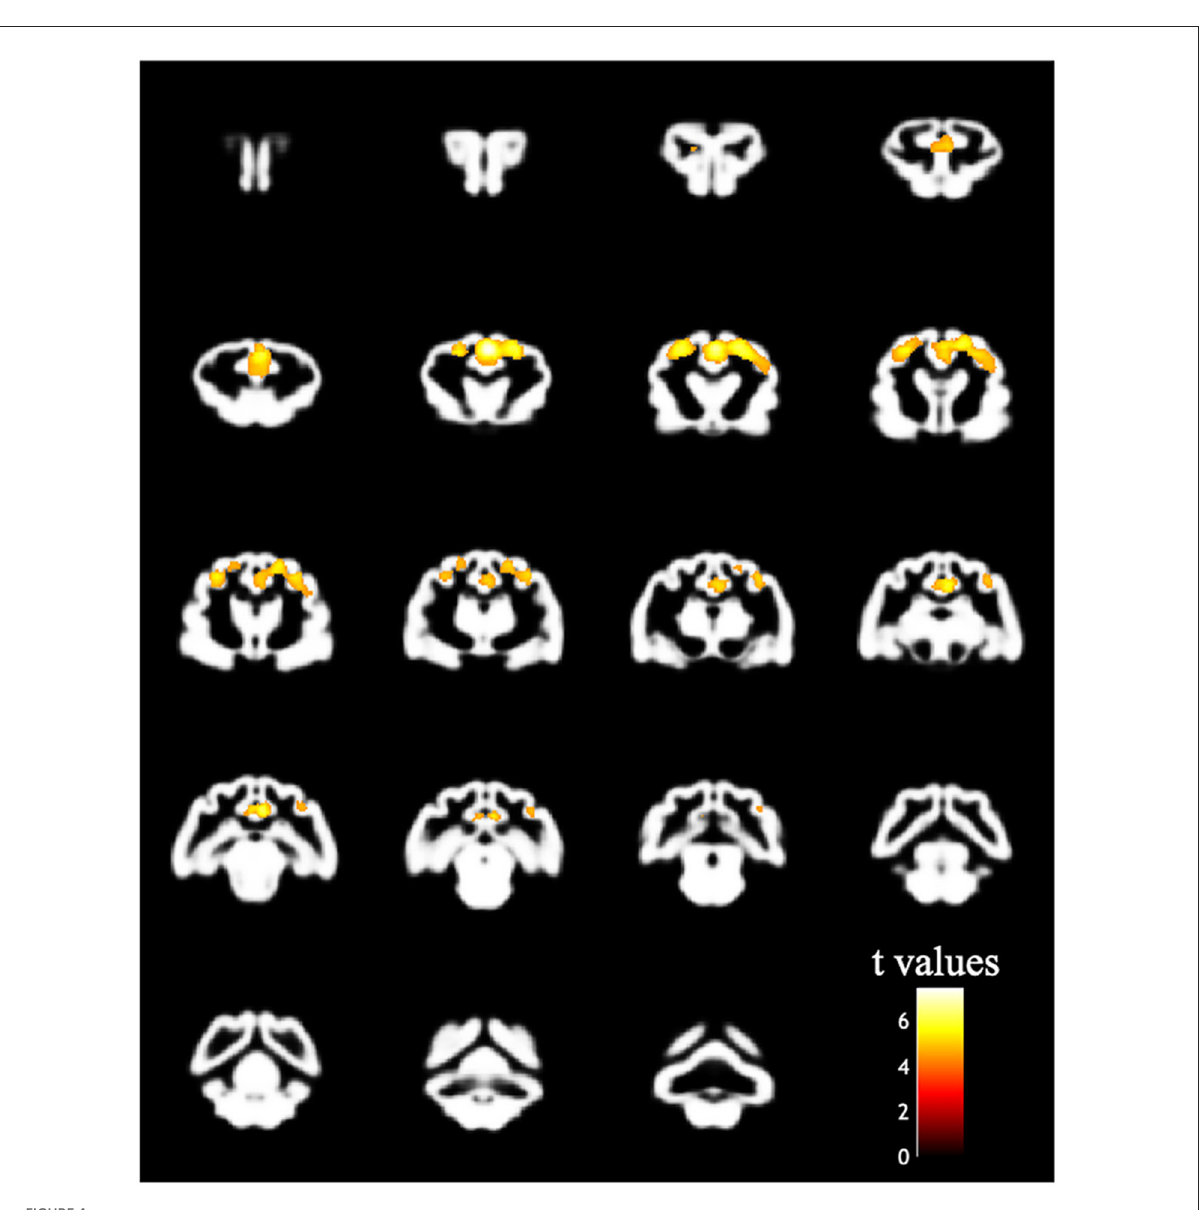
FIGURE4 Result of the VBM analysis in the regional analysis. The colored regions indicate that the family-wise error corrected p value is < 0.05. The decreased bilateral parietal cortex correlated with increased